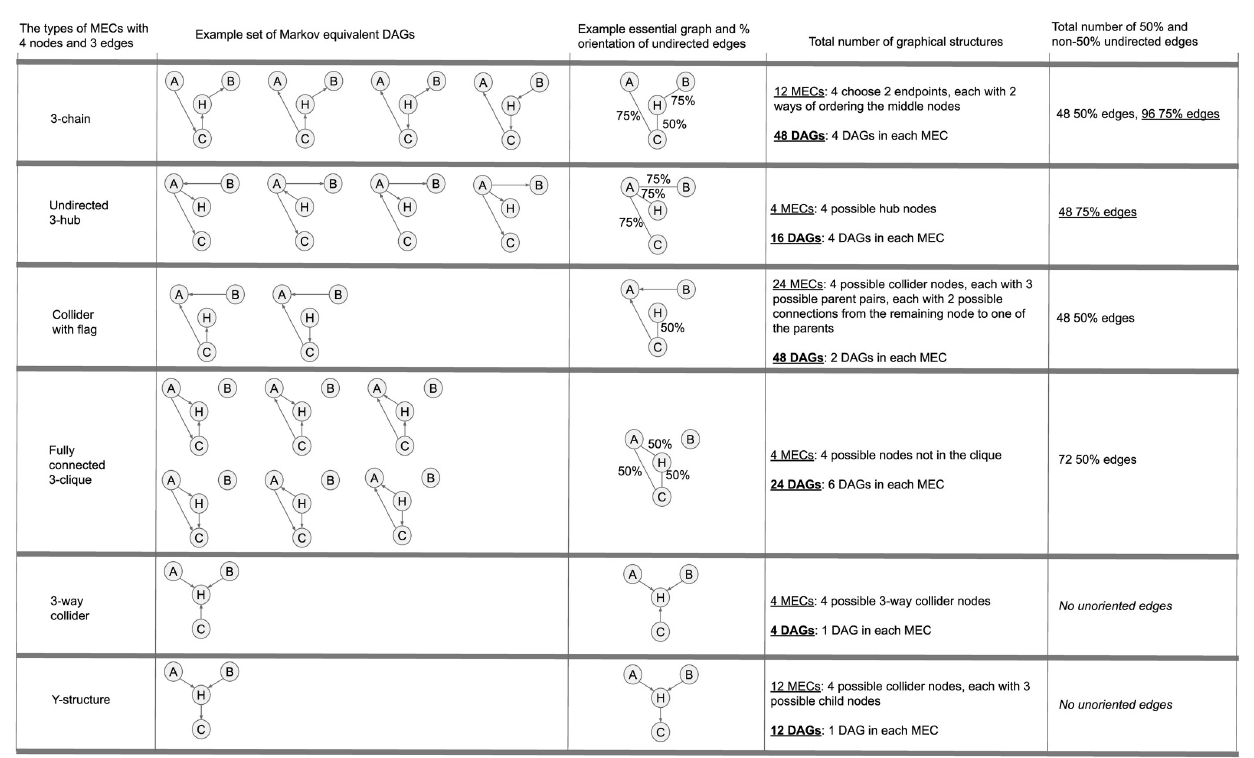
Fig 3. Visualization of examples of the 6 types of Markov Equivalence Classes (MECs), their corresponding essential graphs, the DAGs contained in those essential graphs, the total number of DAGs that fall into each type of essential graph, and the quantity of undirected edges with equal and unequal odds of being oriented in either direction, given a uniform distribution over the DAGs. In addition to undirected hub graphs, undirected chain graphs also contain undirected edges which are more likely to be oriented in one direction. With 4 nodes and 3 edges, other than 50% edges there are only 75% edges and completely directed edges. Overall, 46% of the undirected edges are 75% edges, indicating that non-50% edges are common among graphs with 4 nodes and 3 edges.